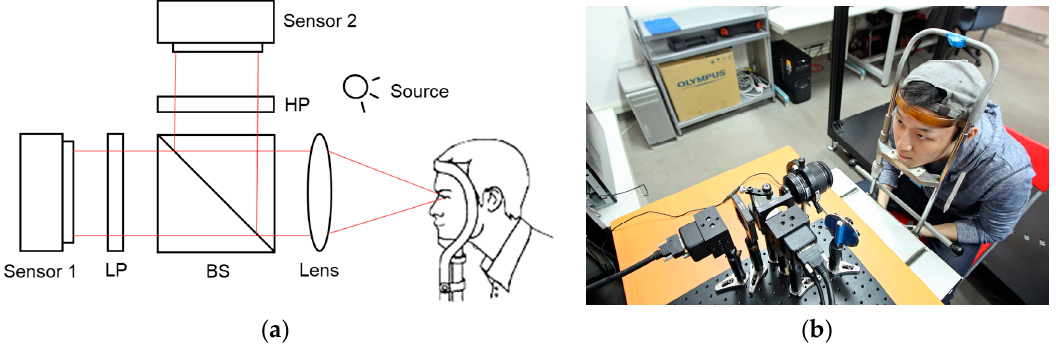
Figure 3. ( a ) The optical layout, where BS: beam splitter, LP: low-pass filter, HP: high-pass filter, the CCL-wearing subject was illuminated by a wideband white light source, two spectral channels (sensor 1 and sensor 2) thus retrieved different spectral imaging (cid:1877) (cid:2919) respectively; ( b ) real system implementation.